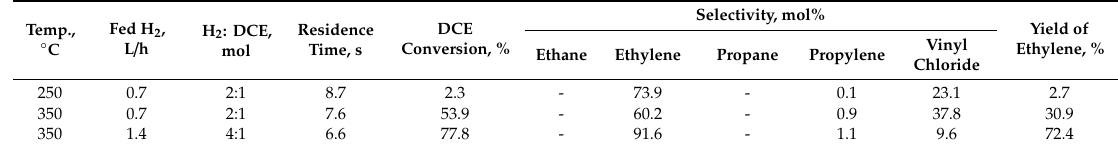
Table 13. Influence of di ff erent parameters on results of 1,2-dichloroethane hydrodechlorination using a catalyst containing 2% Cr 2% Mo on microspheric